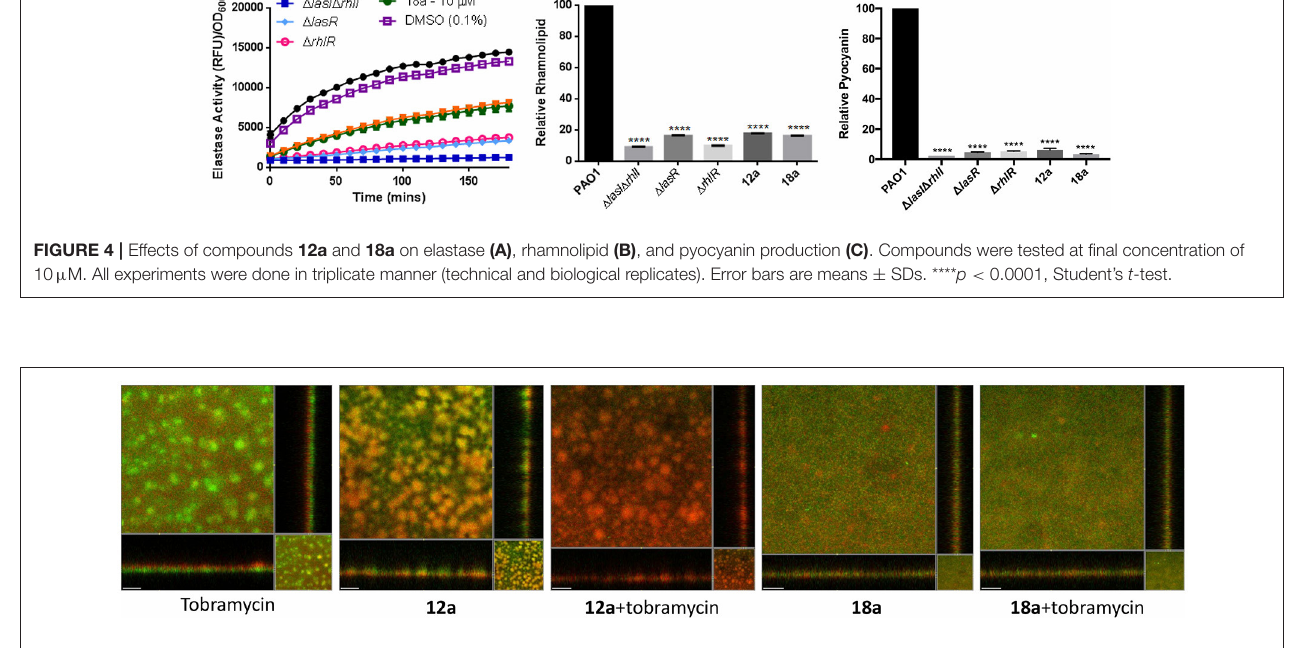
FIGURE 5 | P. aeruginosa biofilms formed on flow cells for 72h, followed by treatment with medium containing antibiotic (tobramycin 10 µ g/ml) and compounds (10 µ M) for further 48h. Live cells are P. aeruginosa tagged with GFP which appeared as green, and dead cells appeared as red. Scale bars, 50 µ m. Experiments were done in triplicate manner (technical and biological replicates), only representative images were